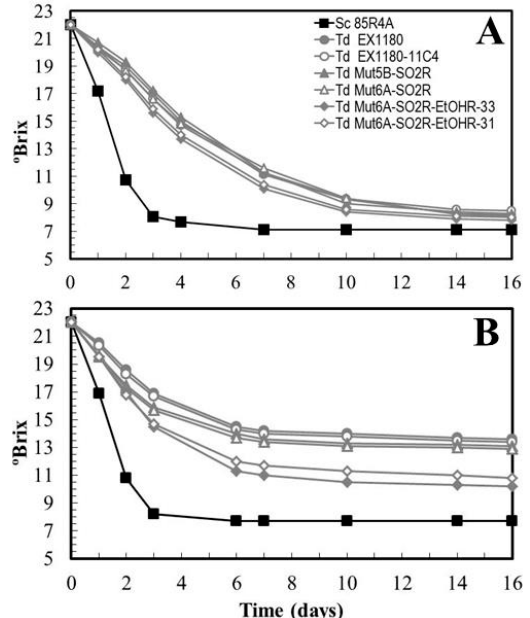
Figure 3. Fermentation kinetics of T. delbrueckii SO 2 resistant mutants ( Td Mut5B-SO2R and Td Mut6A-SO2R) and SO 2 + ethanol resistant mutants ( Td Mut6A-SO2R-EtOHR-31 and Td Mut6A-SO2R-EtOHR-33) in synthetic must ( A ) and synthetic must containing 50 mg/L SO 2 ( B ). Data are the mean values of three fermentations inoculated with each yeast strain. Standard deviations were less than 10% of the means. The degree of dominance throughout fermentation of each inoculated yeast strain was 100%.